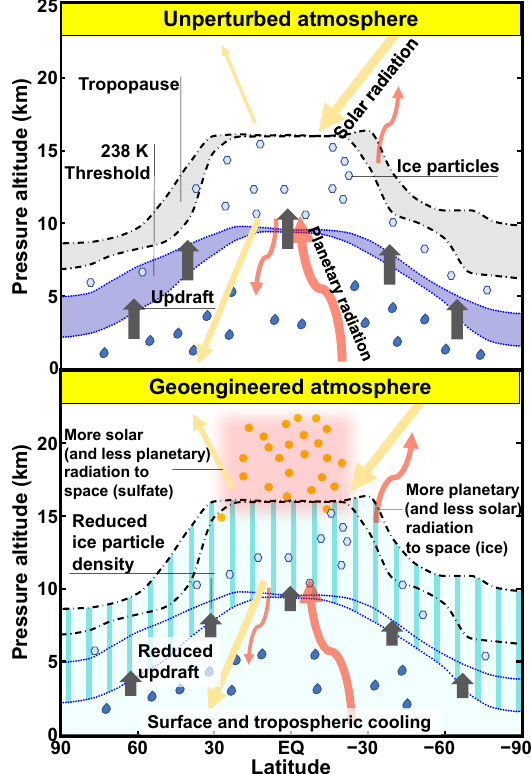
Figure 16. Illustration of the sulfate geoengineering impact on cir- rus ice particles formed through freezing and schematic representa- tion of ice and aerosol changes in radiative